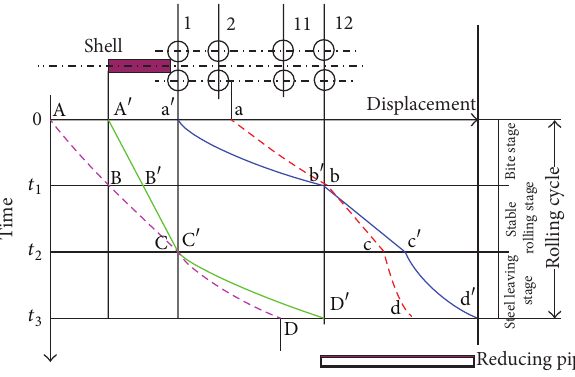
Figure 1: The relation between time and displacement of reducing